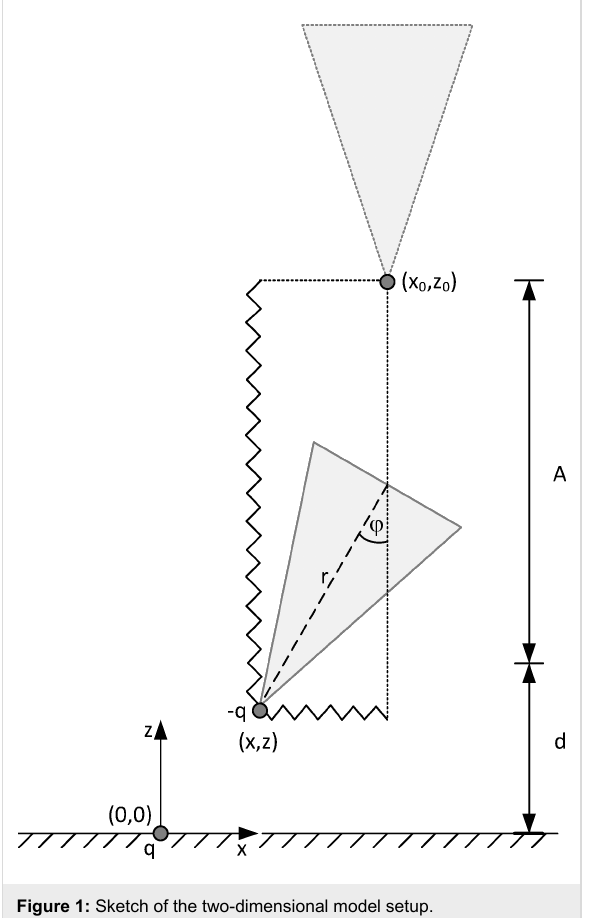
Figure 1: Sketch of the two-dimensional model setup.